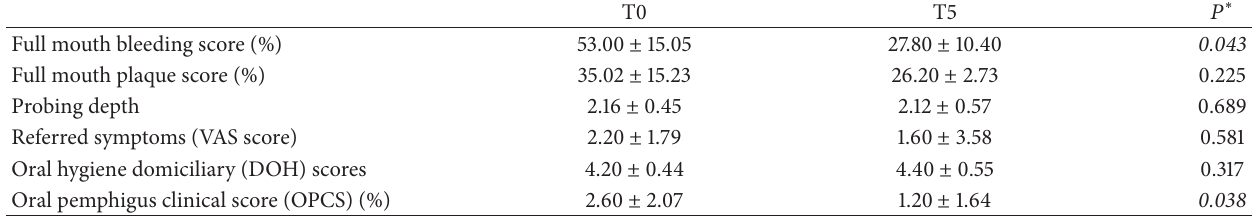
Table 3: The comparison of selected data at time 0 (T0) and at day 126 (T5).